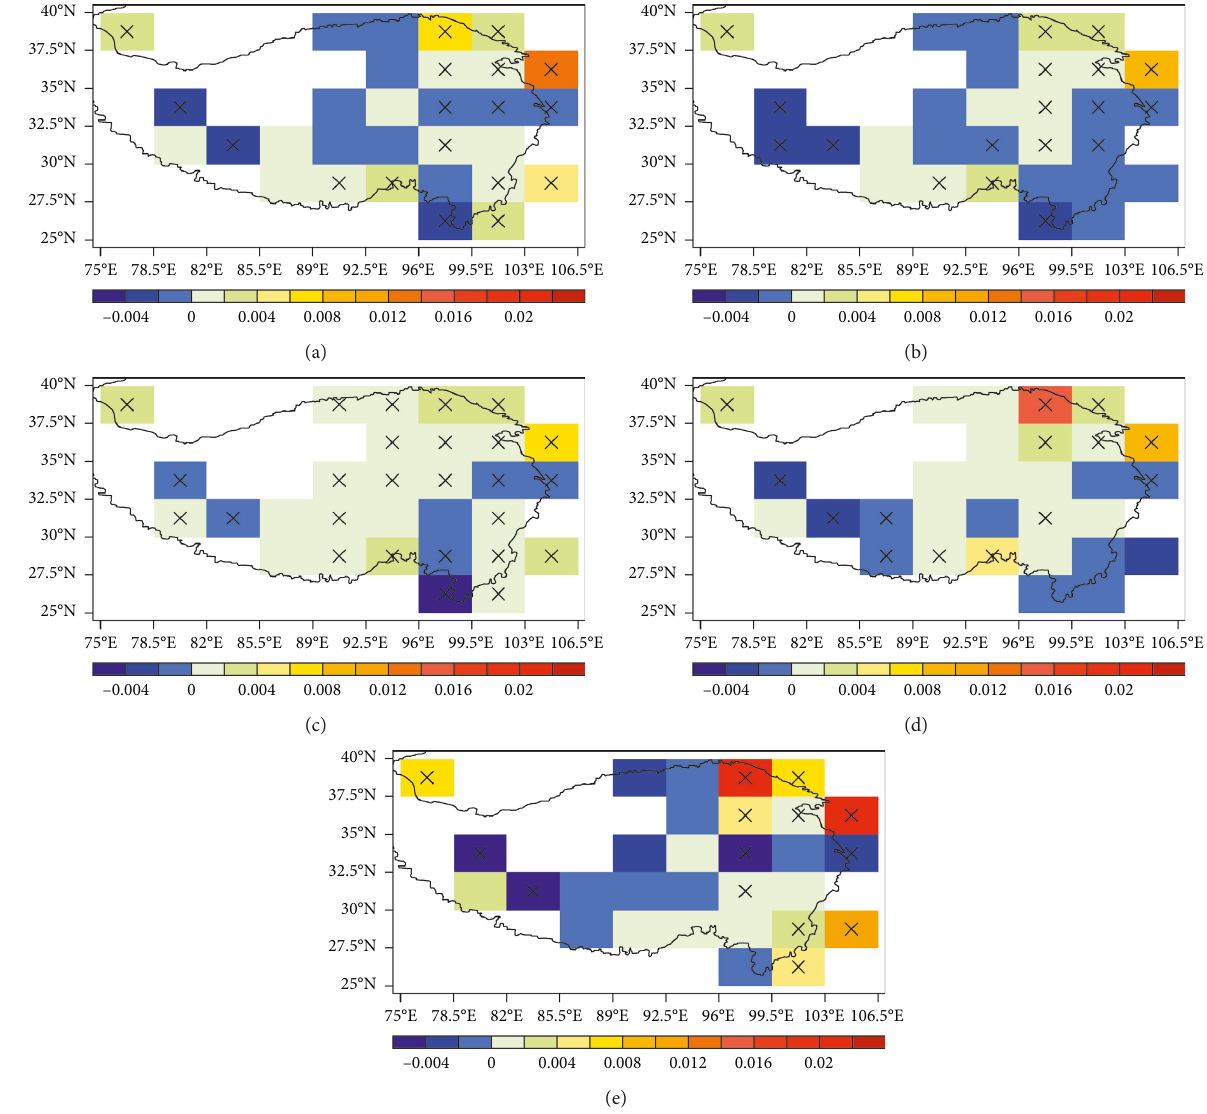
Figure 5: Linear trend of (a) annual and (b–e) seasonal mean sampling error variances for 1979–2012. The × symbol mark denotes values exceeding the 95% significance level. (a) Annual. (b) Spring. (c) Summer. (d) Autumn. (e)